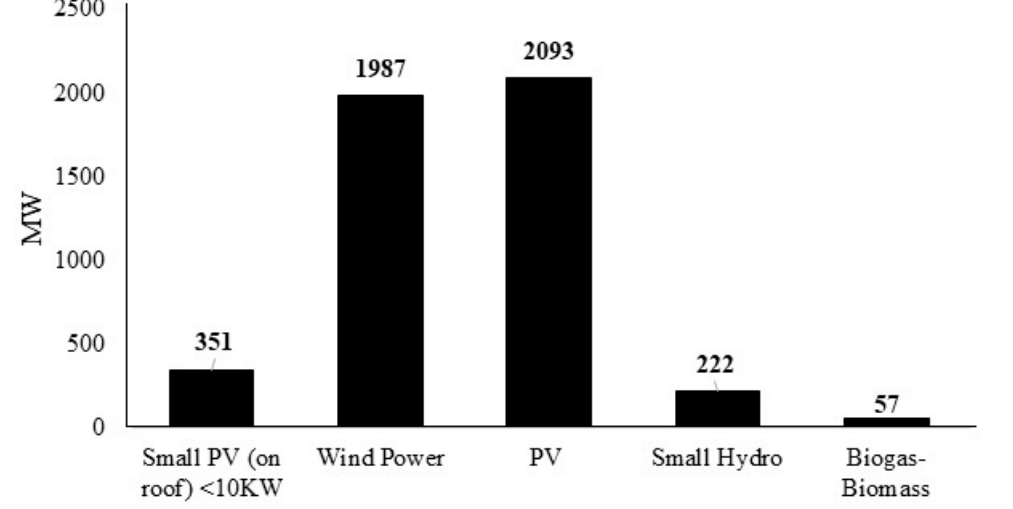
Figure 1. Installed RES (renewable energy sources) in Greece, October 2016 [7].